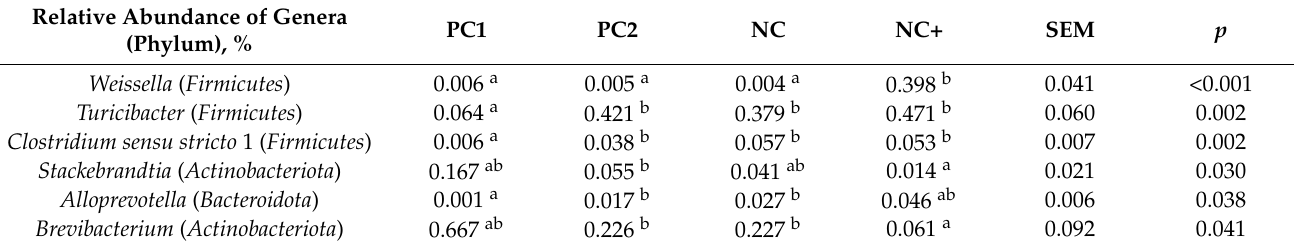
Table 6. Differences in the relative abundance of genera in the jejunal digesta of broilers offered different experimental